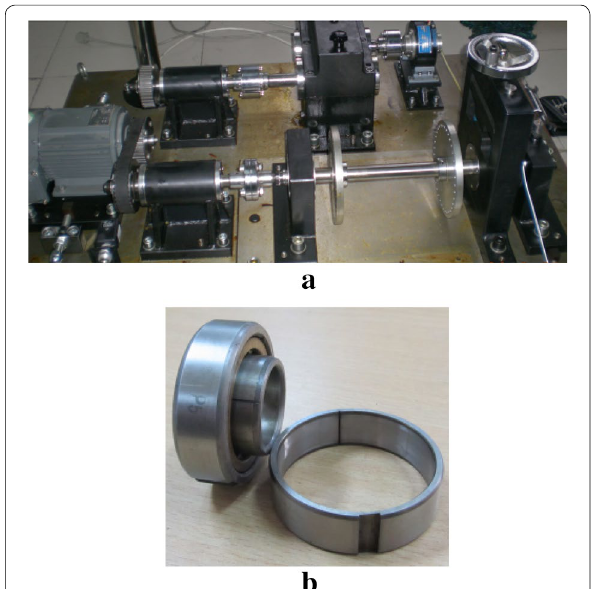
Figure 1 ( a ) Bearing and gearbox fault test rig, ( b ) Outer race and inner race defective bearing